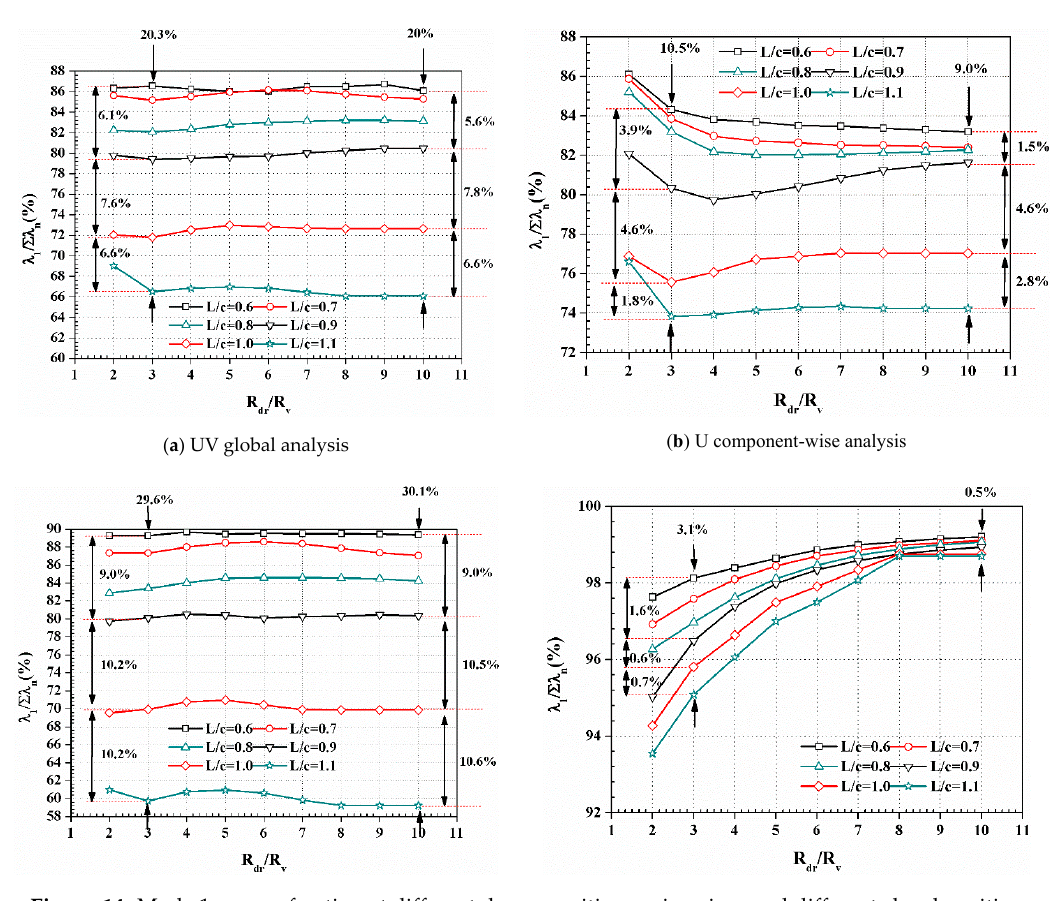
Figure 14. Mode 1 energy fraction at different decomposition region sizes and different chord position.